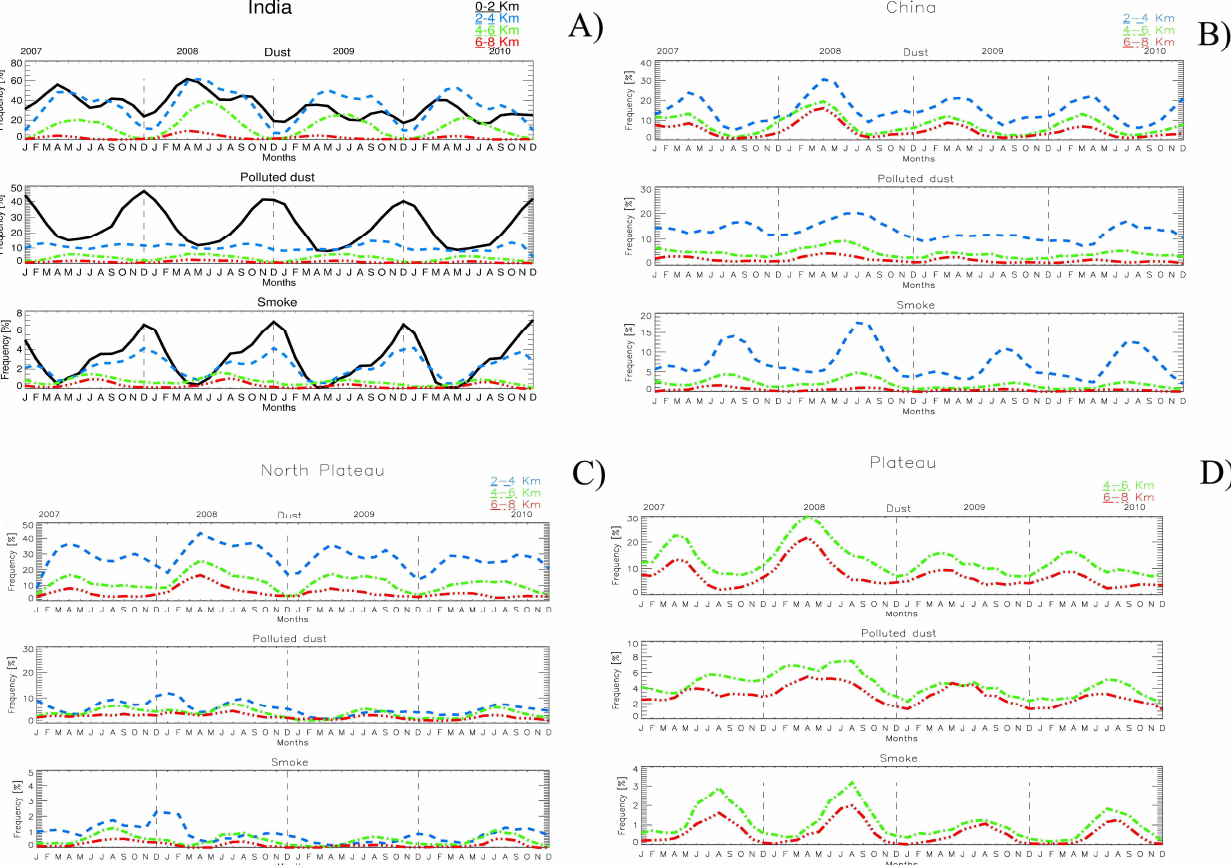
Fig. 5. Frequency of occurrence for dust, polluted dust and smoke for the (A) Pakistan and Western India (20–33 ◦ N, 60–81 ◦ E); (B) north slopes of the plateau (38–42 ◦ N,78–102 ◦ E); (C) eastern China (29–44 ◦ N, 105–120 ◦ E); and (D) Himalayan Plateau (29–38 ◦ N, 78–102 ◦ E) for the years 2007–2010. Different lines report the vertical layers 0–2km (black), 2–4km (blue dashed), 4–6km (green), and 6–8km (red). Readers may note the different vertical scales.